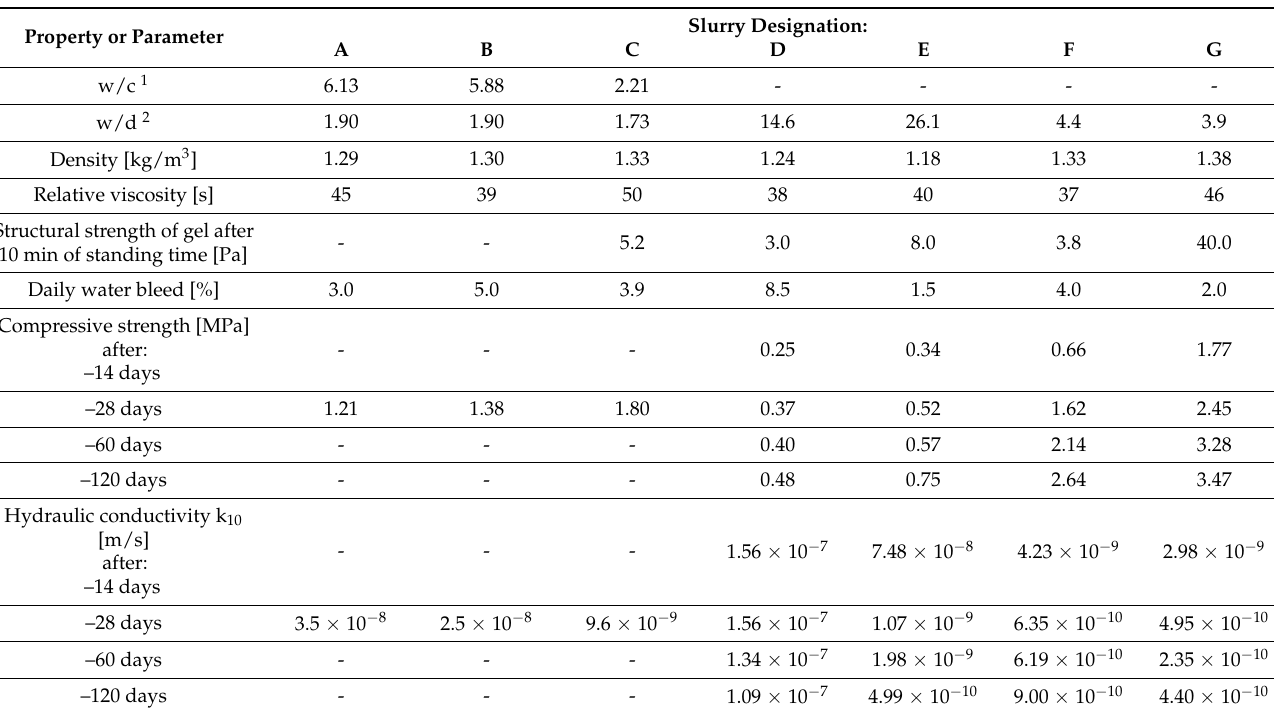
Table 4. Basic properties of tested hardening slurries in liquid and solid